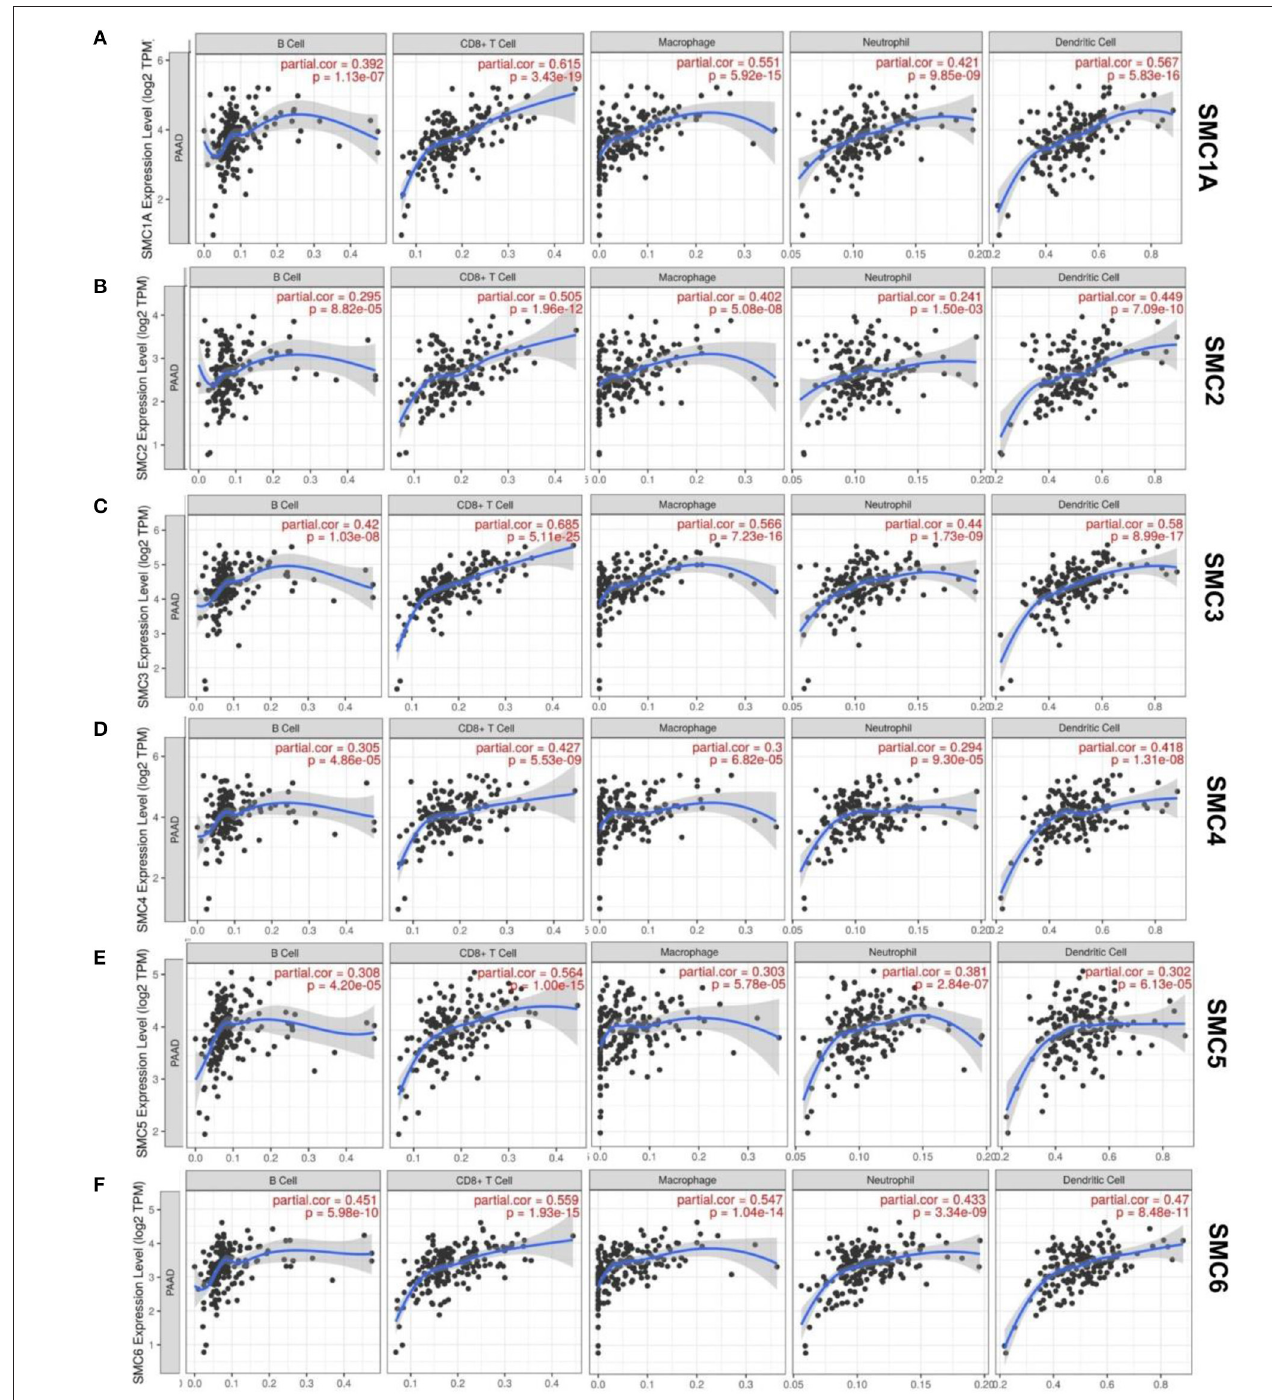
FIGURE 5 | Relationships between SMC protein expression in PAAD patients and immune cell infiltration. (A–F) Correlation between the expression of SMC1A, 2, 3, 4, 5, 6 and the immune infiltration by macrophages, neutrophils B, CD8 + T, and dendritic